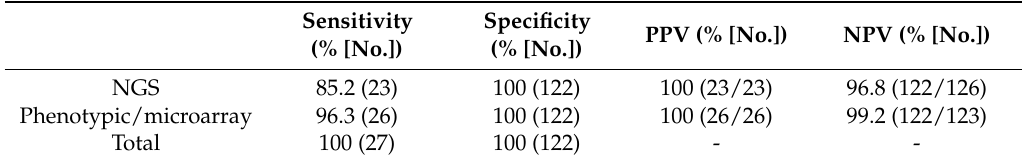
Table 2. Sensitivity, specificity, PPV and NPV for the amplicon-based next-generation sequencing method (NGS) and the phenotypic/microarray method.